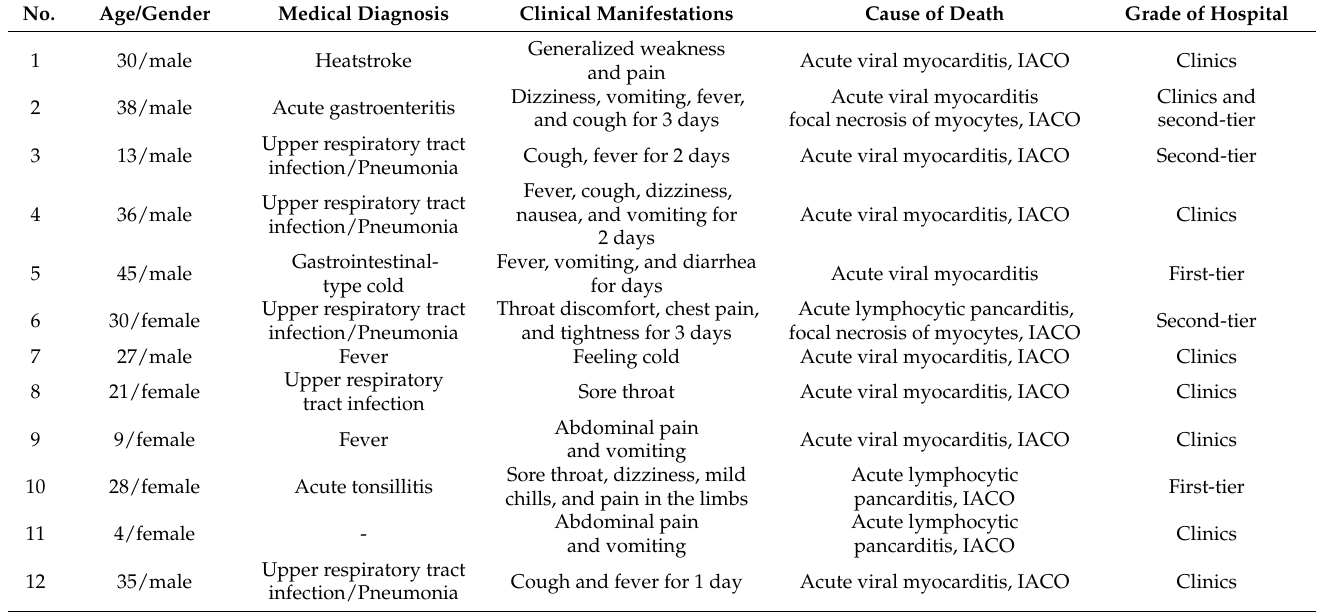
Table 2. The demographic characteristics of the 21 cases of rapid